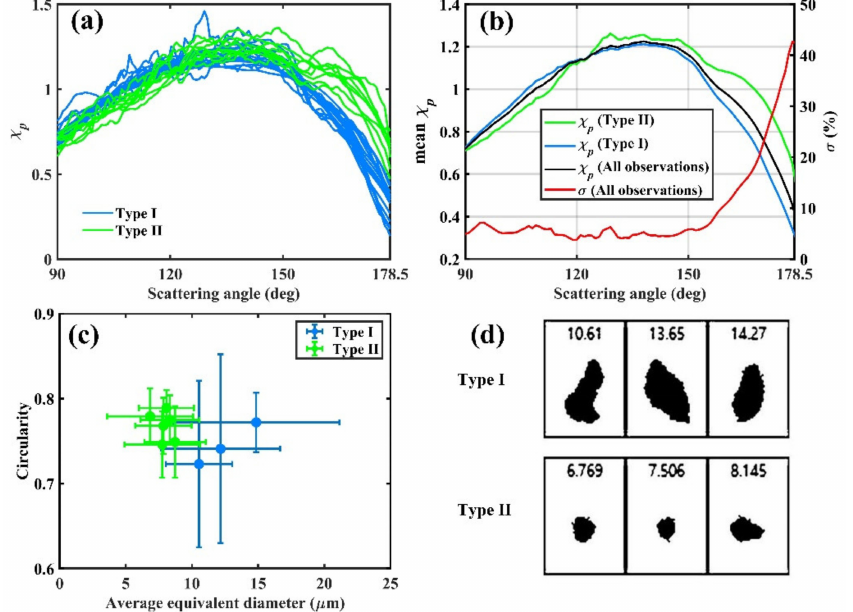
Figure 9. ( a ) χ p of two types of water from 90 ◦ to 178.5 ◦ . ( b ) Average χ p (black line) and relative standard deviation for all observations (red line) from 90 ◦ to 178.5 ◦ . The blue and green lines represent mean χ p of type I and II, respectively. ( c ) Scatter plot between degree of circularity and mean equivalent diameter. ( d ) Microscopic images of typical particles taken by BT-3000. The unit is